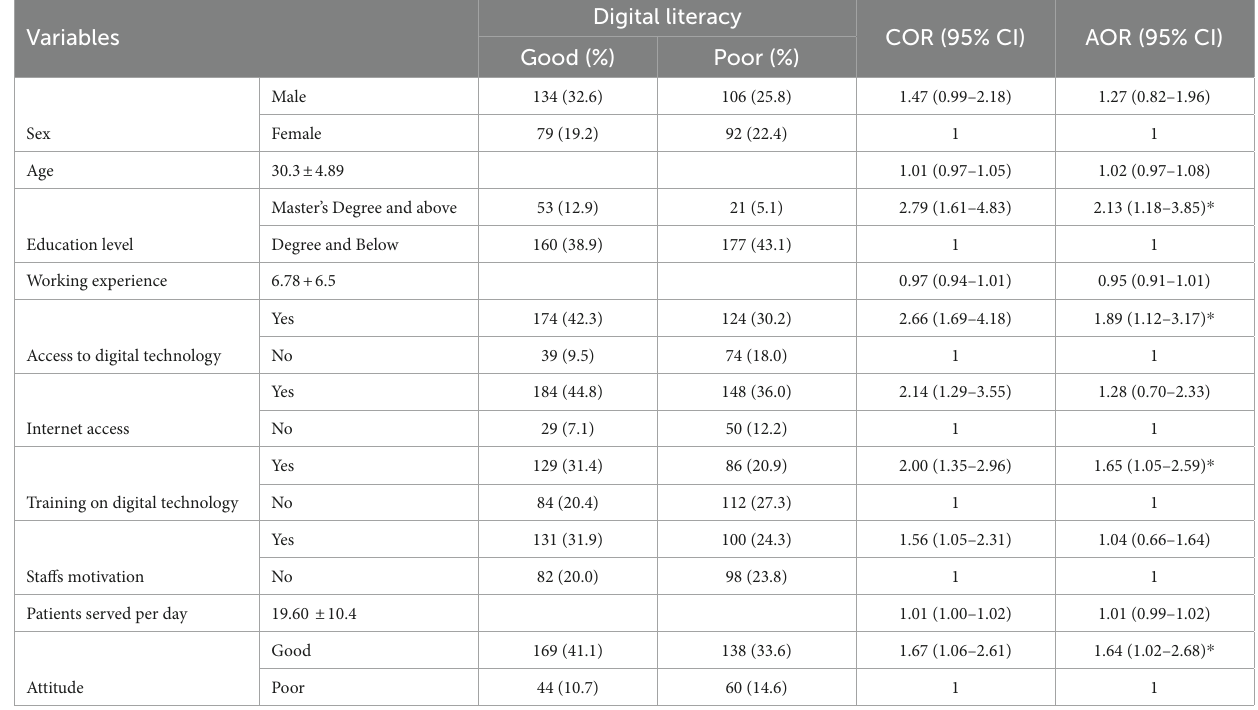
TABLE 5 Factors associated with health professionals’ digital literacy level.